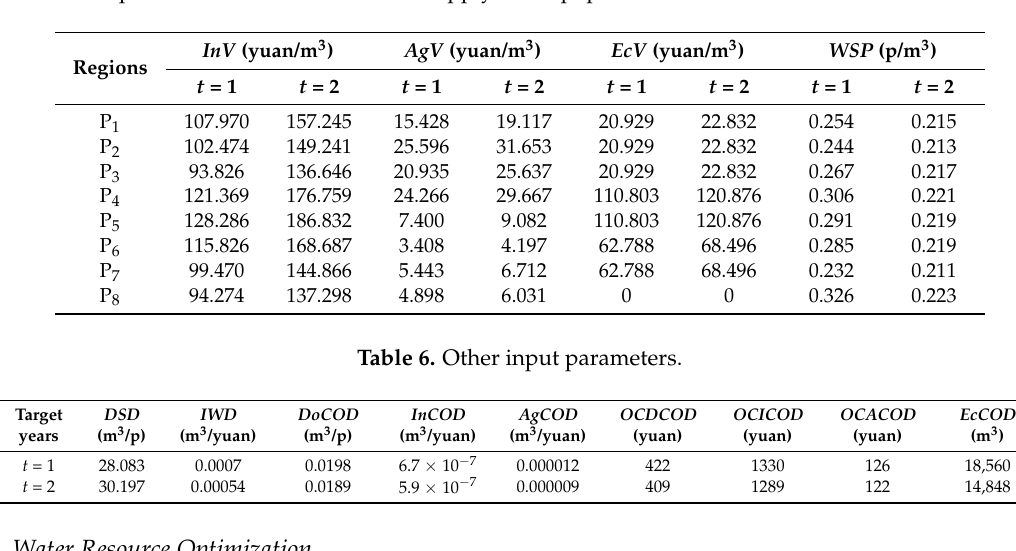
Table 5. The added value of the industrial, agricultural, and environmental sectors per unit of water resources produced relative to the water supply to the population.